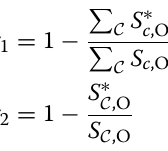
increase in rate is so low that it does not lead to a reduc- tion of n in (7) by at least one. The convergence is hence guaranteed by the limitation of n to integer values.